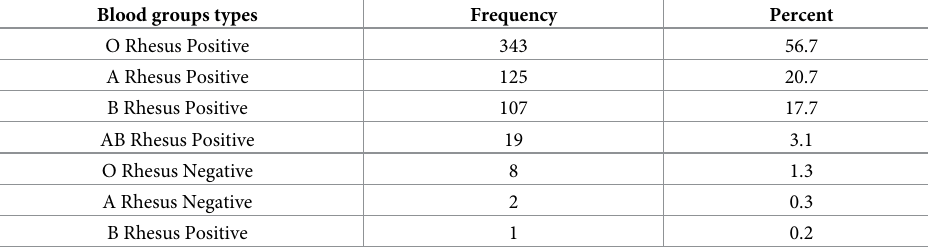
Table 1. Distribution of blood group types among voluntary school-going adolescents’ blood donors at KSBTC, January 2020-June 2021 (n = 605). Blood groups types